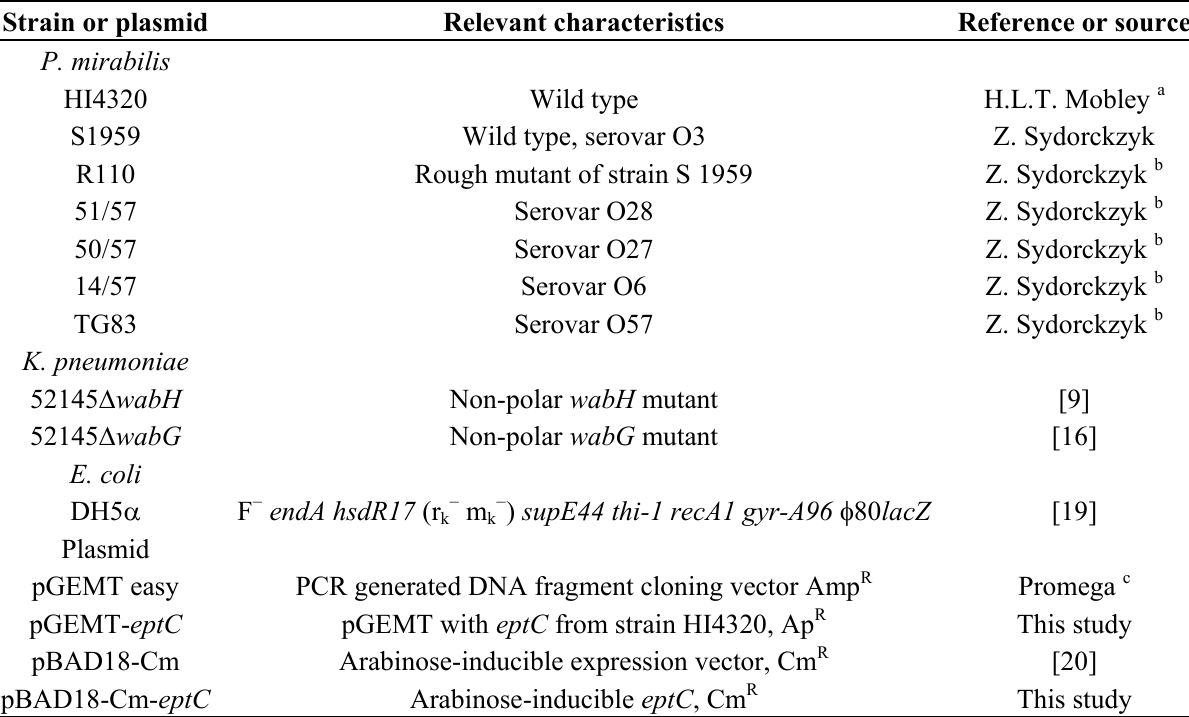
Table 2. Bacterial strains and plasmids